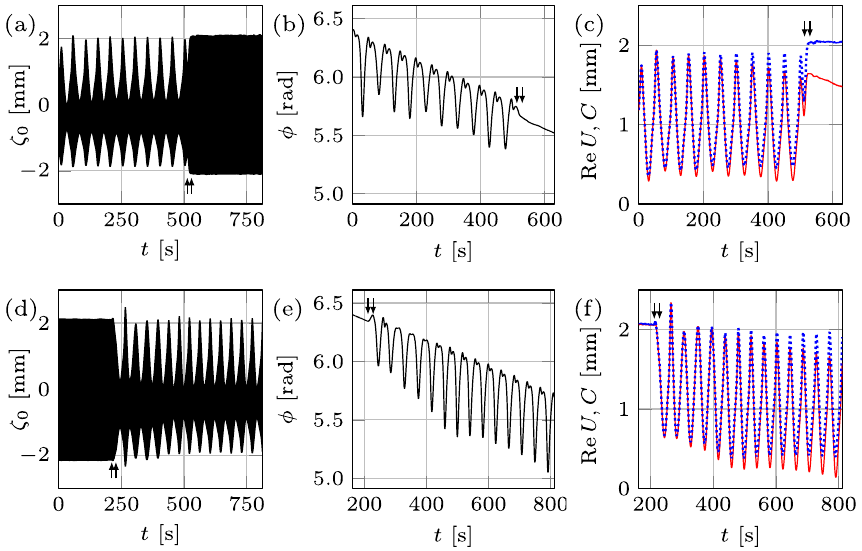
Figure 2. Regime change in response to domain deformation at f = 12.33 Hz and A = 1.26m s − 2 . Top (bottom) row represents domain growth (shrinkage) by (cid:31) L = 2 mm at a rate 0.06mm s − 1 , over which the regime changes from chaotic (periodic) to periodic (chaotic). ( a , d ) The surface deformation ζ 0 ( t ) within the arrows indicates the start and finish of wall motion. ( b , e ) The slow phase φ . In ( c , f ) the amplitude envelope C and the real part of the slow amplitude Re U are shown by blue dotted and red solid curves, respectively.